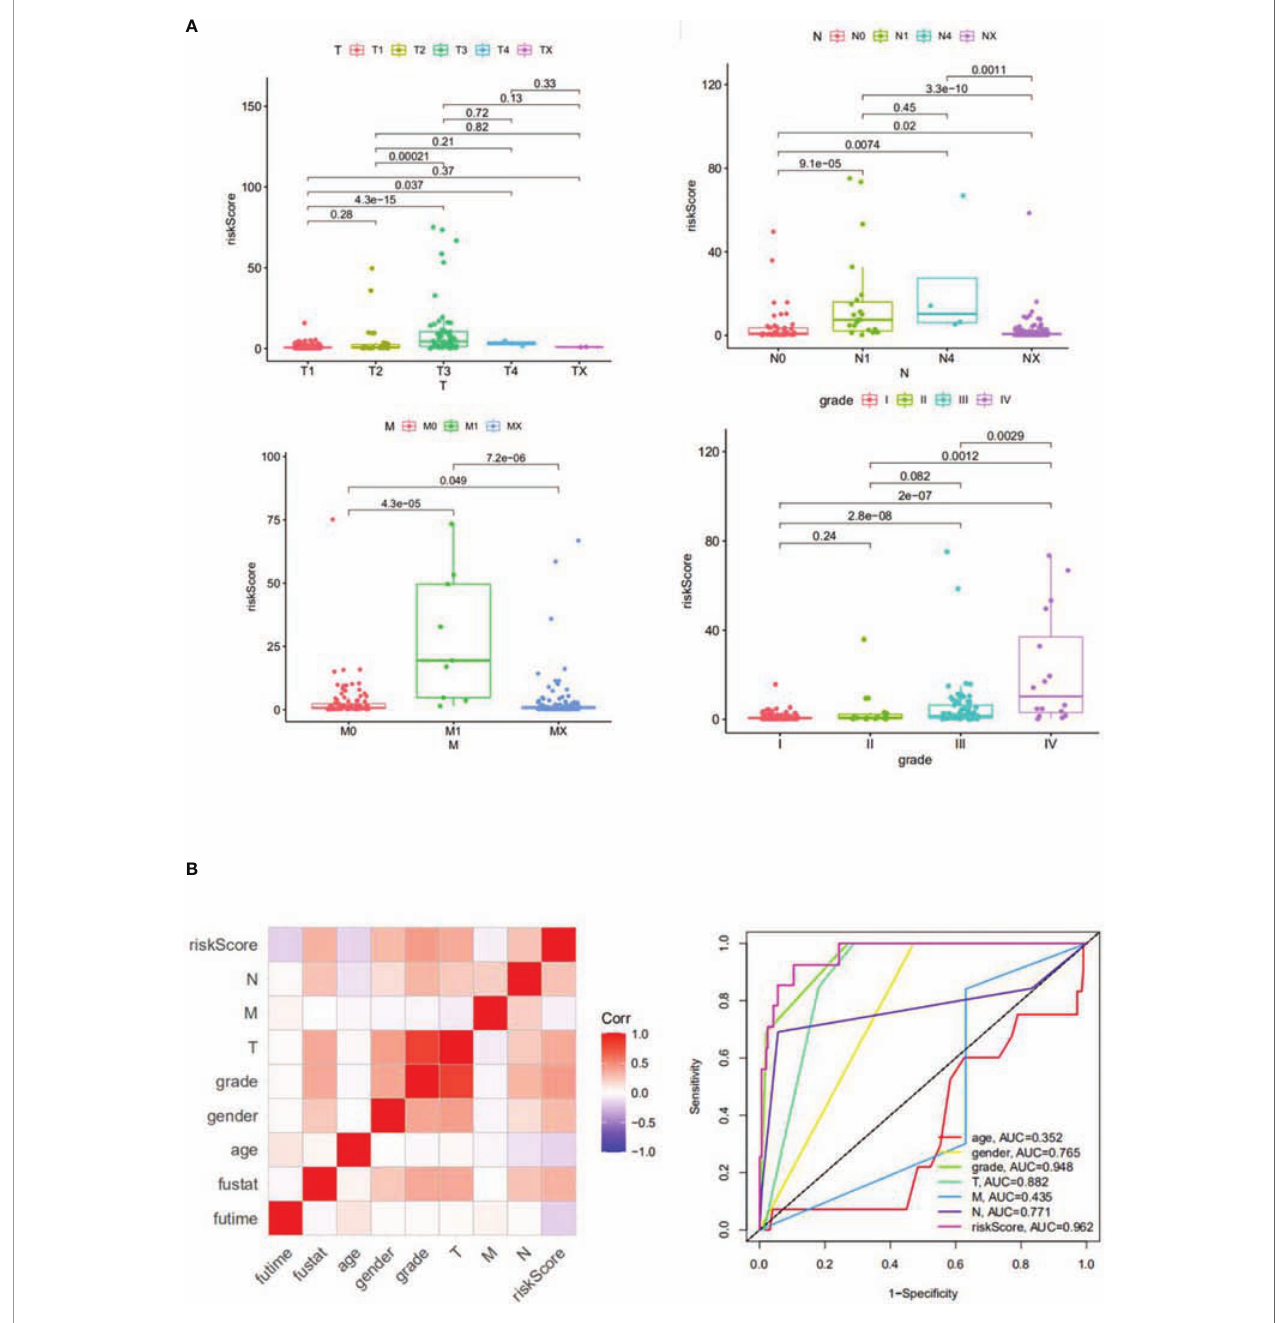
FIGURE 6 | The correlation between the risk score and clinical classi fi er. (A) The correlation between the risk score and TNM grade information; (B) the